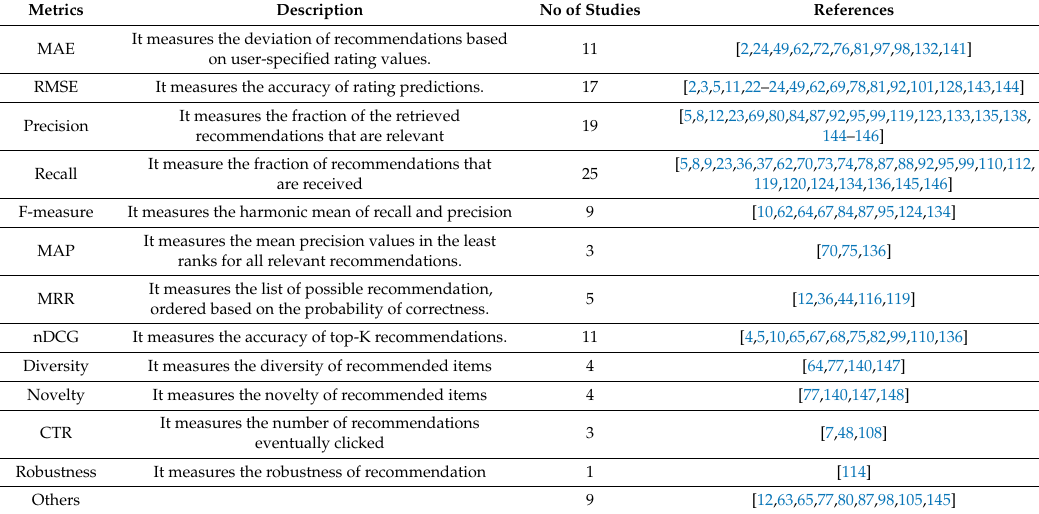
Table 6. Distribution of the Evaluation